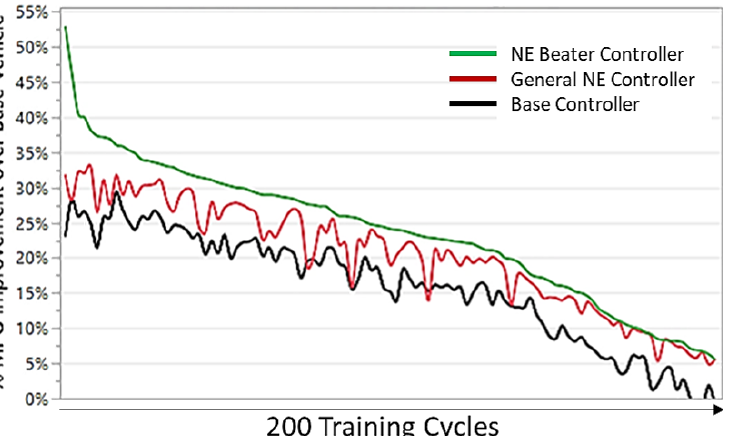
Figure 8. MPG improvement over the base IC vehicle over the 200 training cycles for three controllers: Conventional, General NE, and Cycle Beater